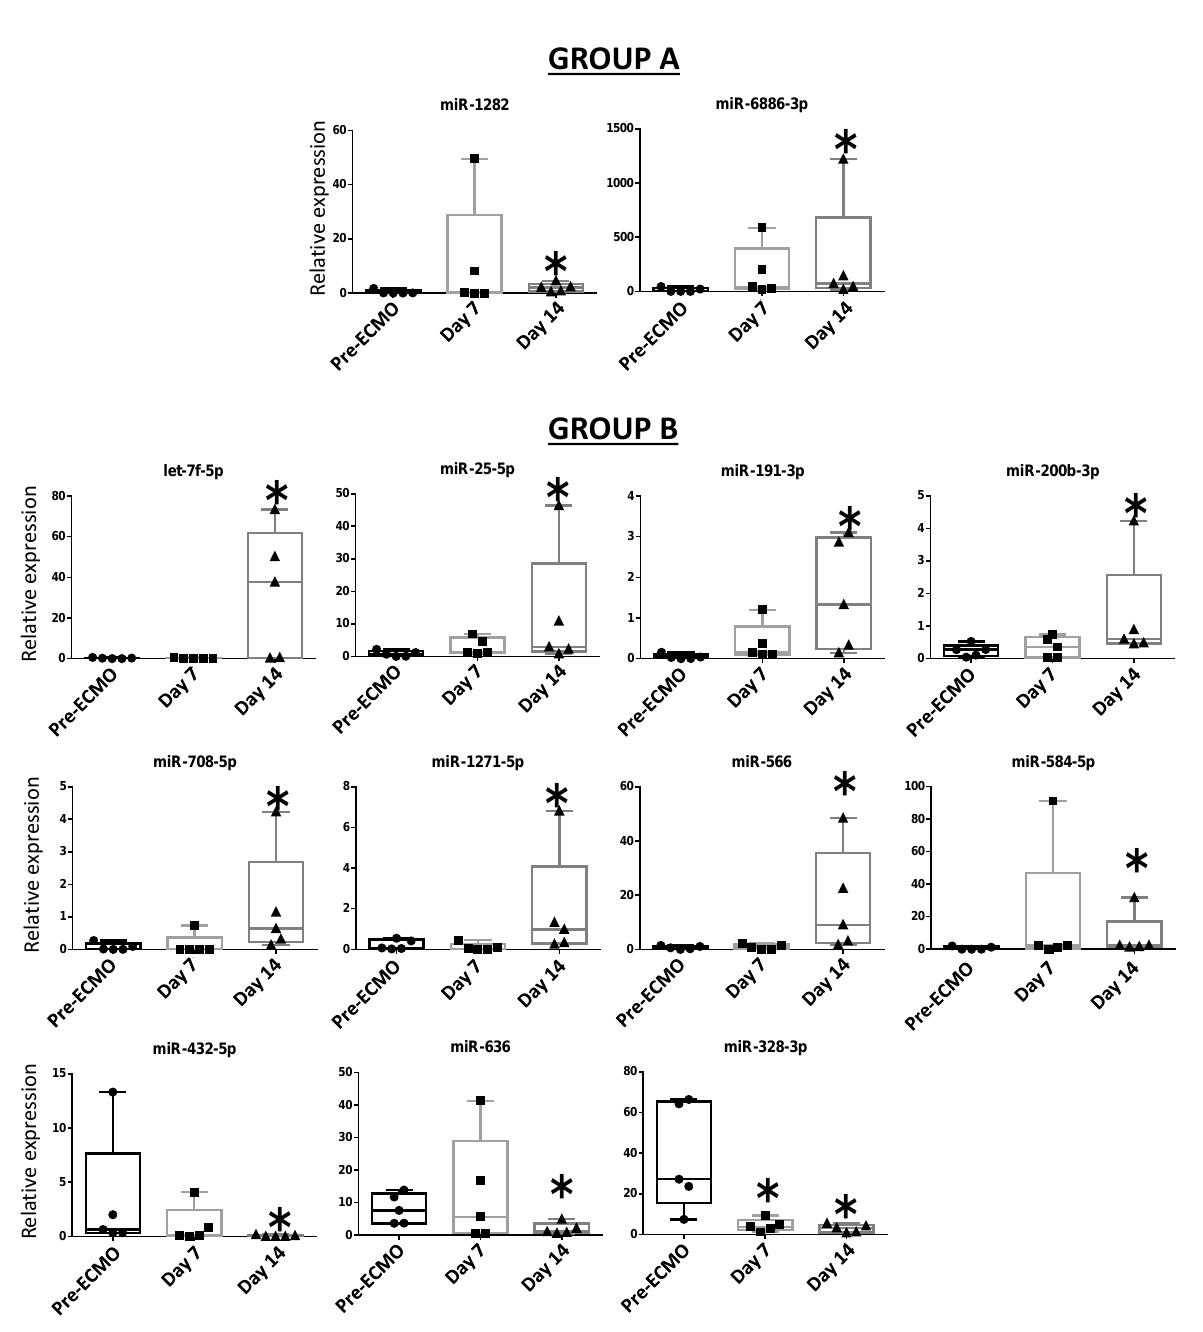
Figure 2. Blood expression levels of thirteen miRNAs in group A and group B patients after 7 and 14 days of ECMO support. Data are presented as expression relative to U6. Box plots are displayed where the horizontal bar represents the median, the box represents the IQR, and the whiskers represent the maximum and minimum values. Comparisons were made by Mann–Whitney U test. * p < 0.05.